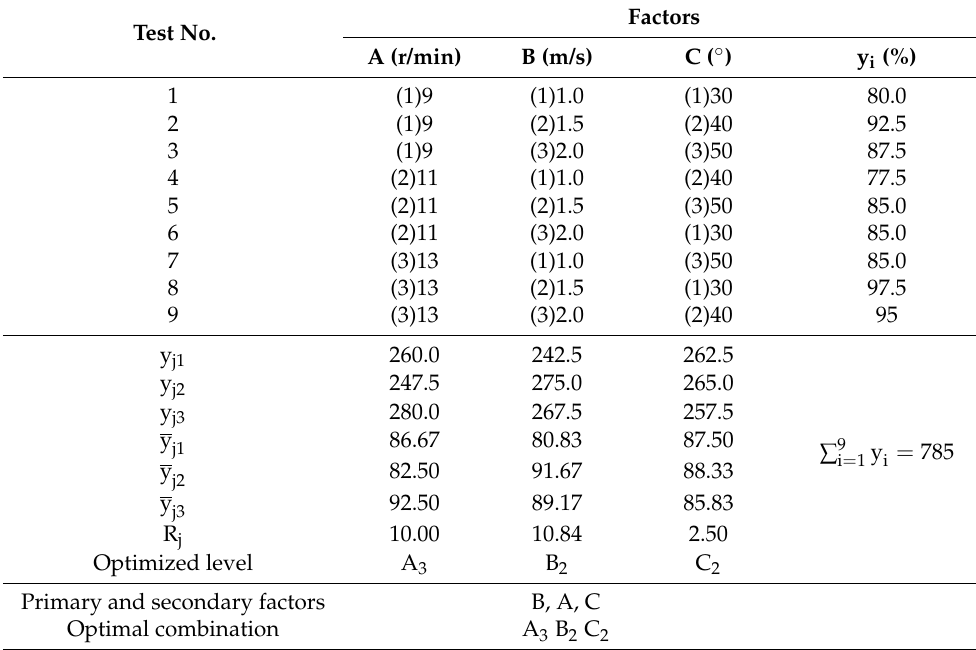
Table 4. Results of range